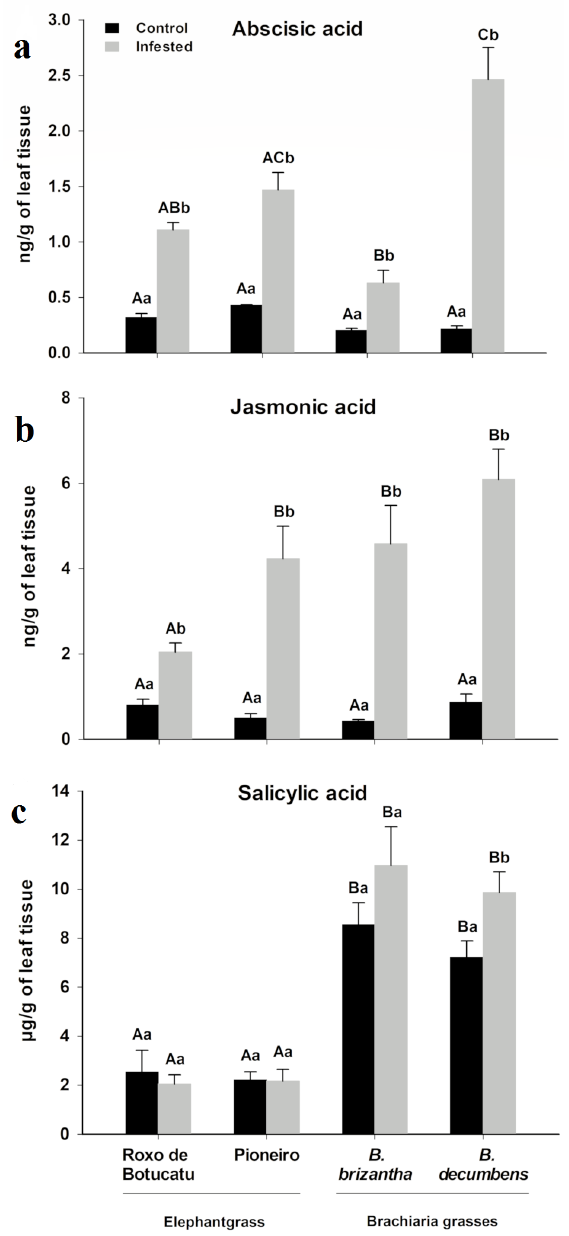
Figure 2. Concentrations of abscisic acid (a), jasmonic acid (b) and salicylic acid (c) in leaves of different forage grasses (cvs. Roxo de Botucatu and Pioneiro of elephant grass, B. brizantha , and B. decumbens ) infested or not (control) with Mahanarva spectabilis . Bars (mean ± SE; n = 4) with the same lowercase letters indicate no significant difference between control and infested treatments and those followed by the same capital letters indicate no significant difference among forage grasses within same treatment (Tukey’s test: P <